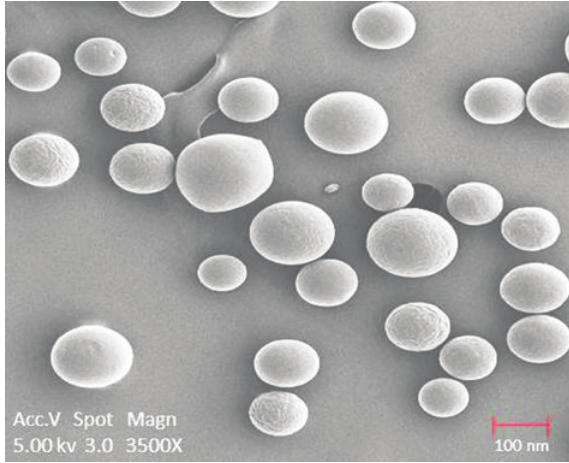
Figure 4: TEM analysis of nanoparticles.